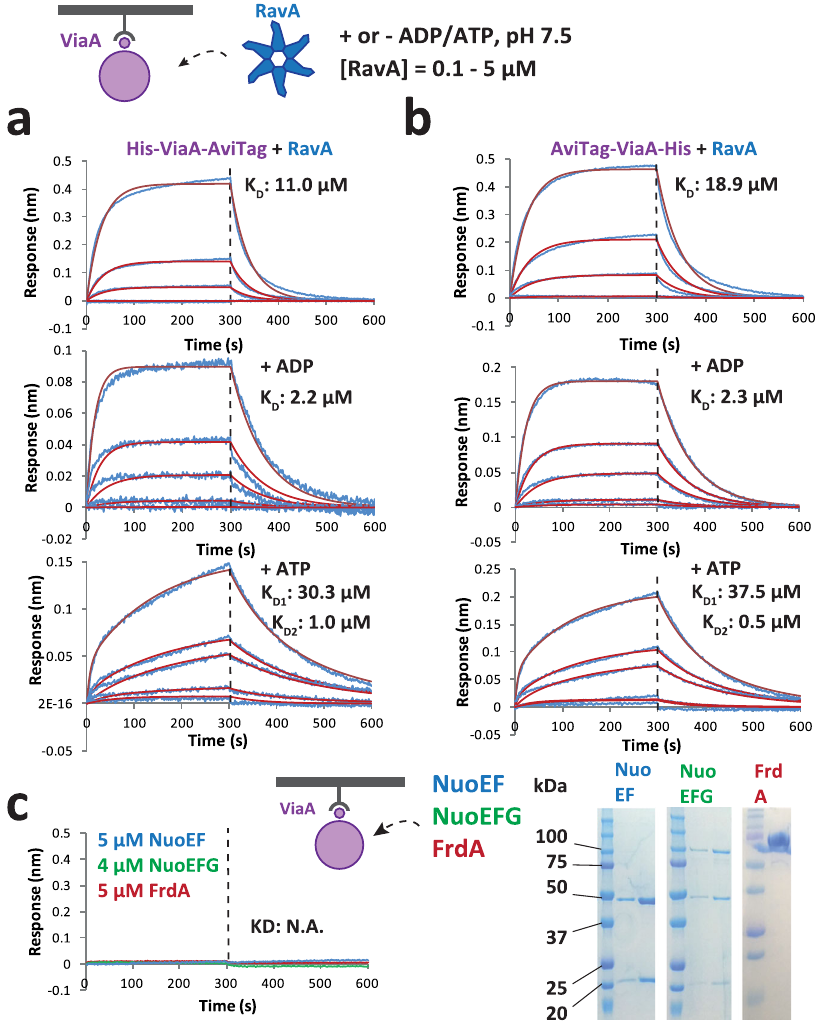
Fig. 2 | Characterization of the ViaA-RavA interaction by Bio-Layer Inter- ferometry(BLI)bindingstudies.a & b BLImeasurementsofHis-ViaA-AviTag( a )or AviTag-ViaA-His ( b ) coupled on BLI biosensors and RavA, with or without added ADP/ATP. The blue curves correspond to the measured signalwhilethe red curves correspond to the calculated fi t using a 1:1 (no nucleotide, ADP) or 2:1